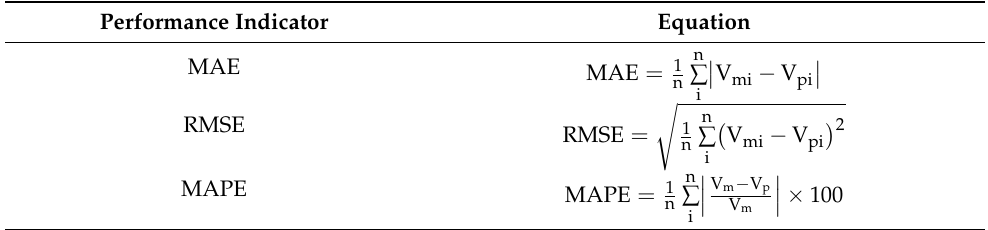
Table 6. Equations of performance indicators.